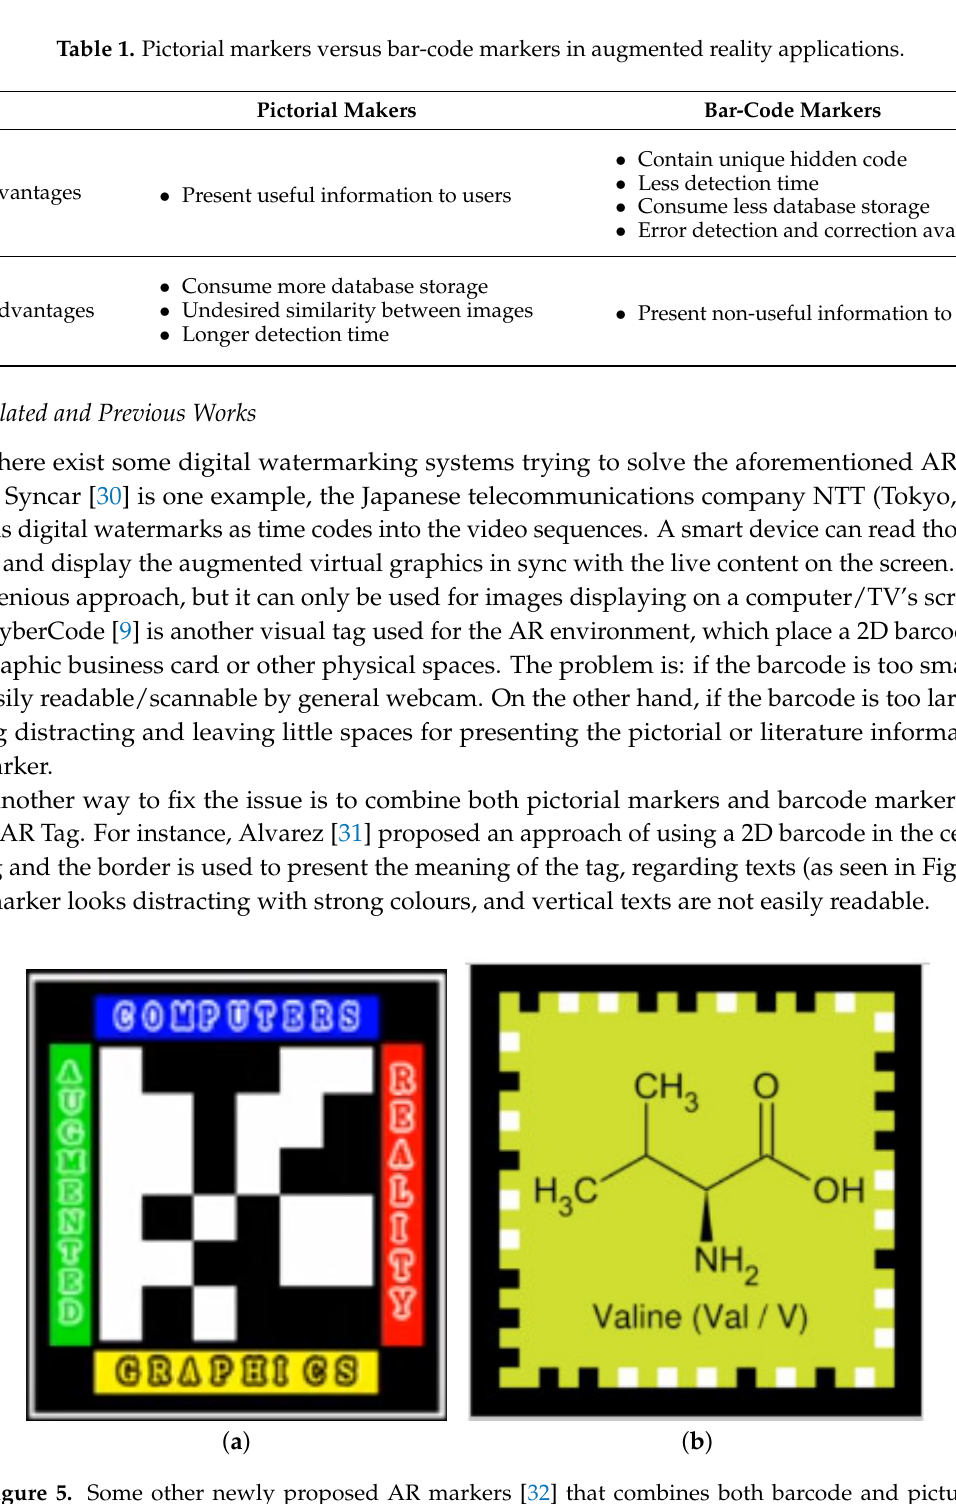
Figure 5. Some other newly proposed AR markers [32] that combines both barcode and picture. ( a ) Alvarez Marker; ( b ) Vuforia